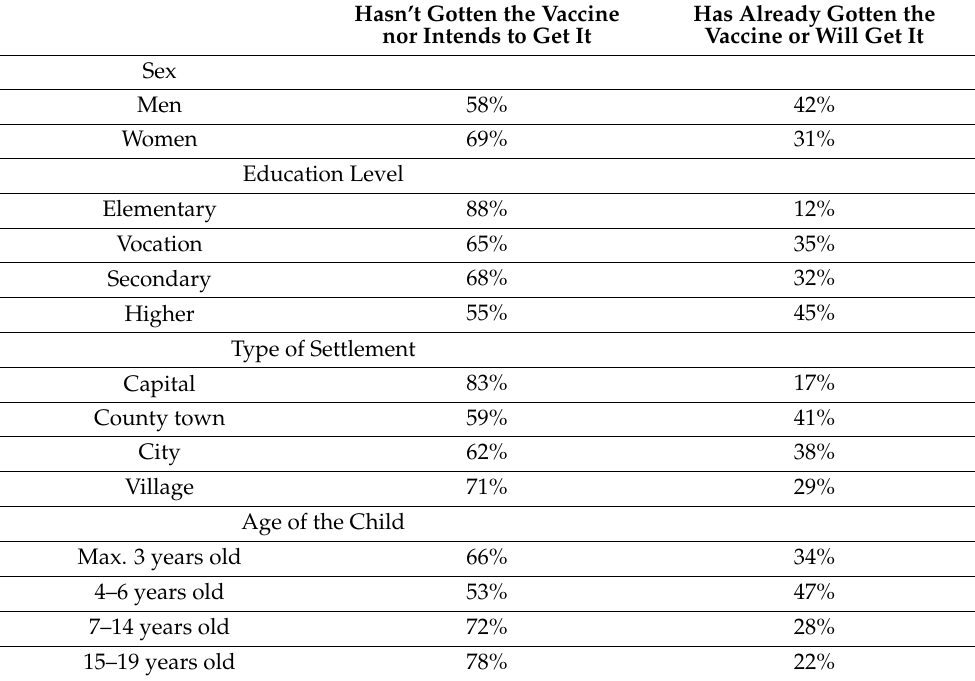
Table A8. Crosstabulation of the attitude towards the Piresian vaccine with different socio- demographic dimensions. Row